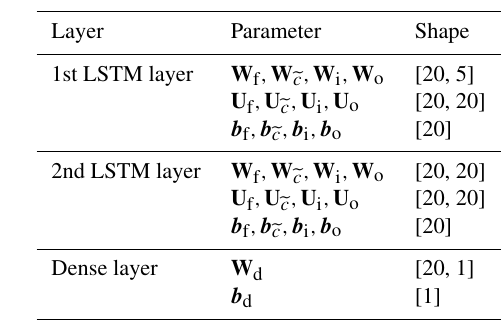
Table 2. Shapes of learnable parameters of all